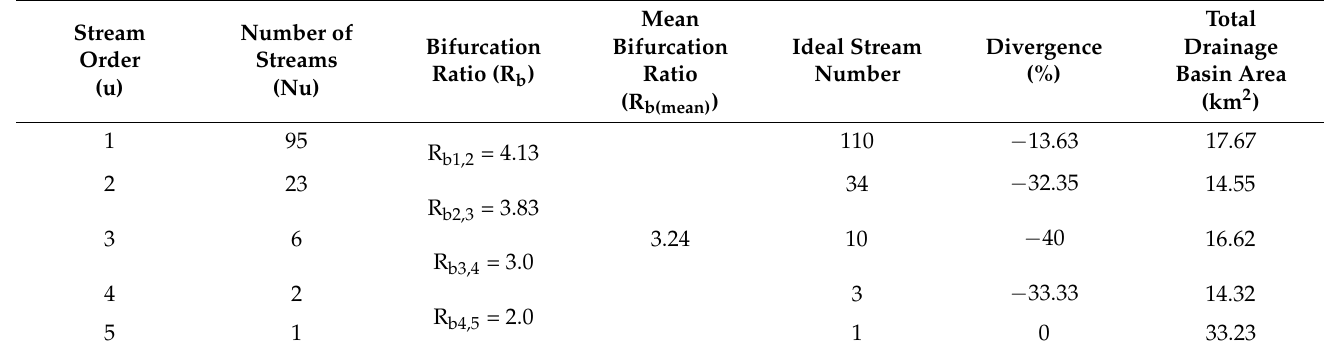
Table 2. Hydromorphological relations for the Kladeos River